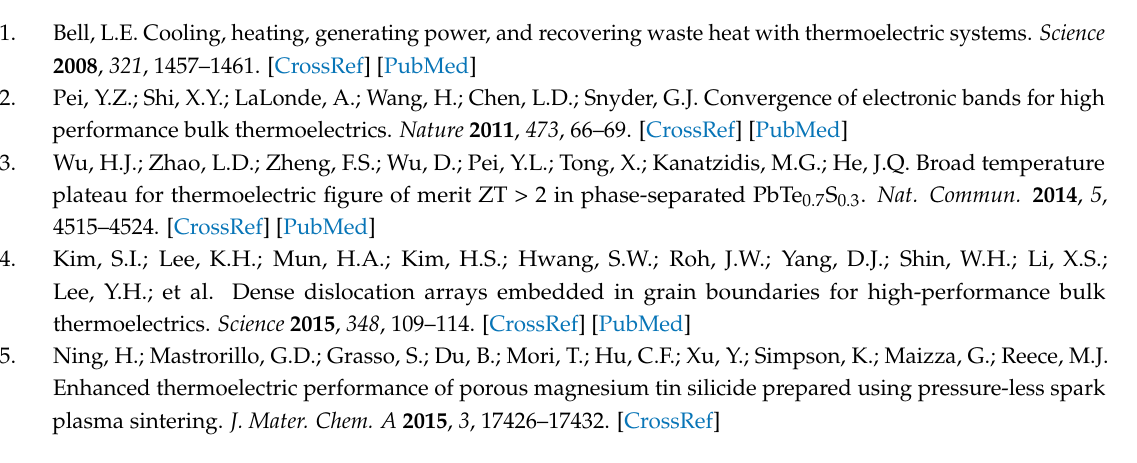
Figure 5. ZT values as a function of temperature for all the samples SnSe- x wt% LaCl 3 ( x = 0.0, 0.5, and 1.0).